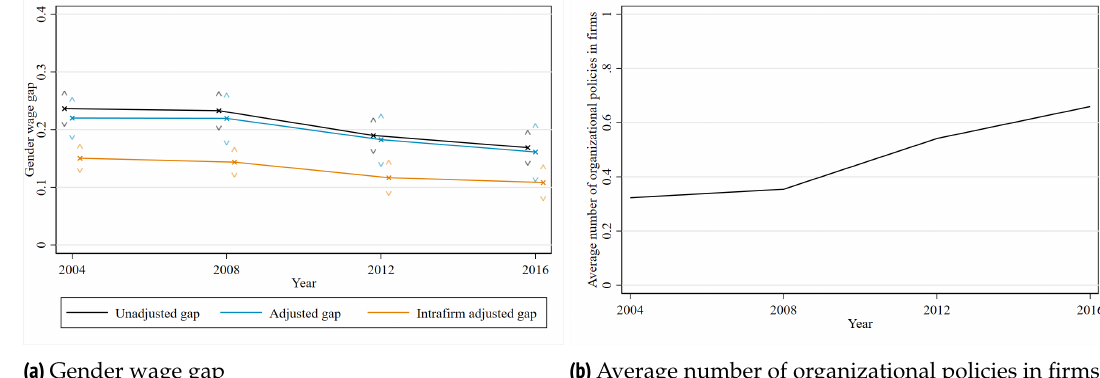
Figure 3: Gender wage gap and number of organizational policies in firms. Notes: The gender wage gap is measured in log points. The adjusted gap accounts for individual-level control variables, that is, work experience, its square, tenure, its square, migration status, three dummies for education, and 13 dummies for occupation. The number of observations is 956,777 employee observations in 1,415 firms in (a) and 5,660 firm-years from 1,415 firms in (b). To improve clarity in (a), the point estimates, that is, the x symbols, of different lines are staggered, although each point estimate is measured at the same point in time. The whiskers in (a) represent the 95 percent confidence interval. Standard errors are clustered at the firm level. Source: Own calculations using the LIAB QM2